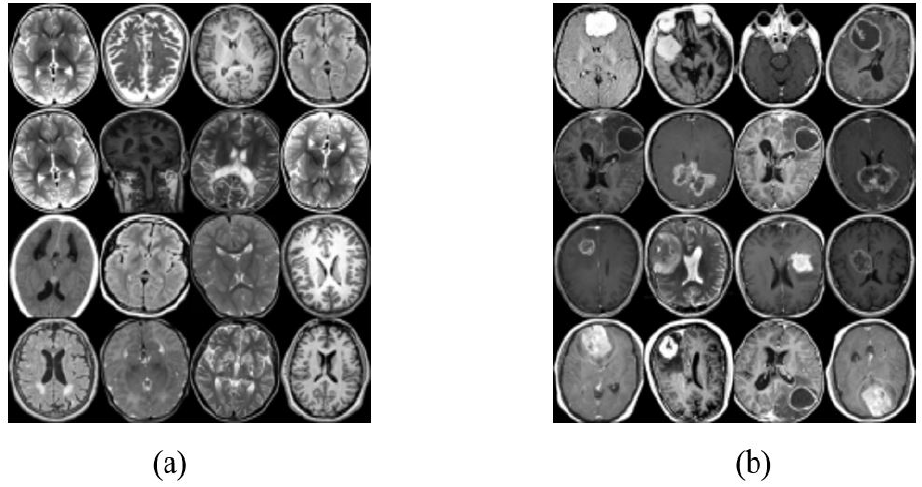
Figure 3. MRI scan images for two classes ( a ) No tumor samples images, and ( b ) Tumor sample images.